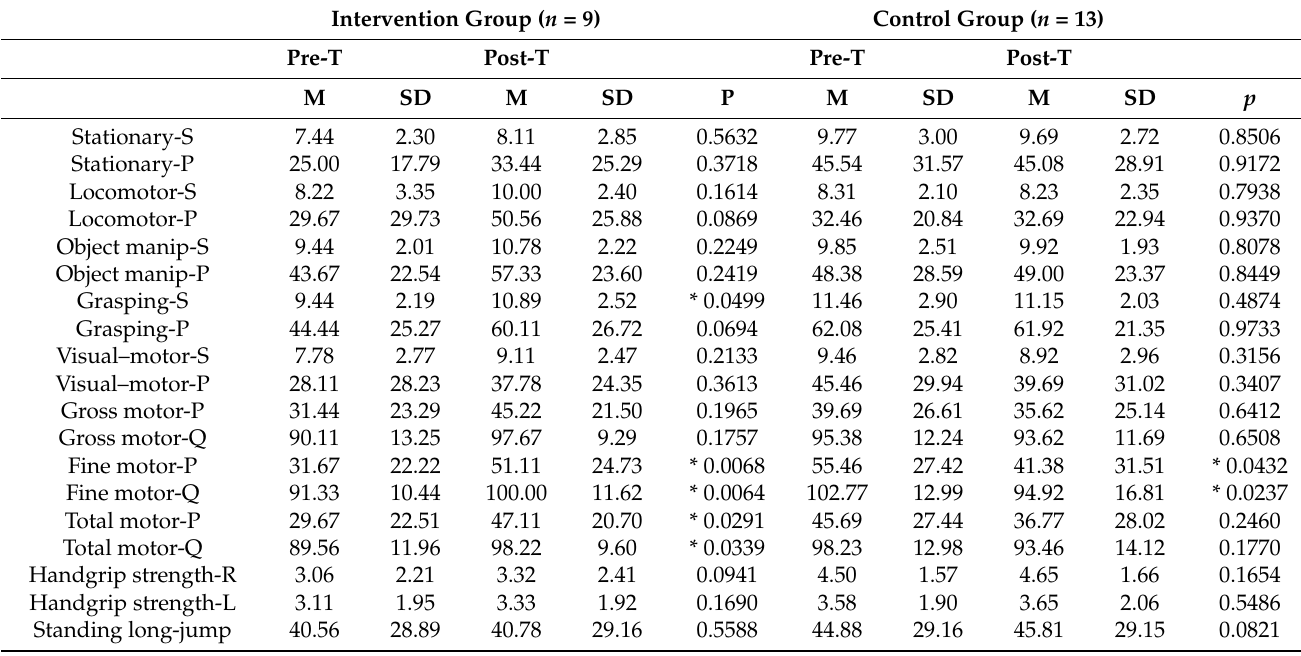
Table 3. Comparison between the pre-test and the post-test in the intervention and control